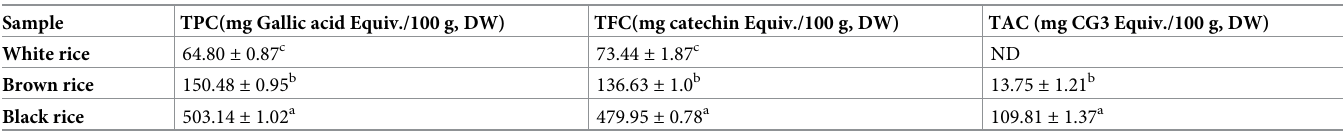
The findings are presented as the mean ± SD of triplicate. Statistically, significant differences are represented by different alphabetical letters in each column (Tukey and Duncan test p � 0.05). DW stands for dry weight